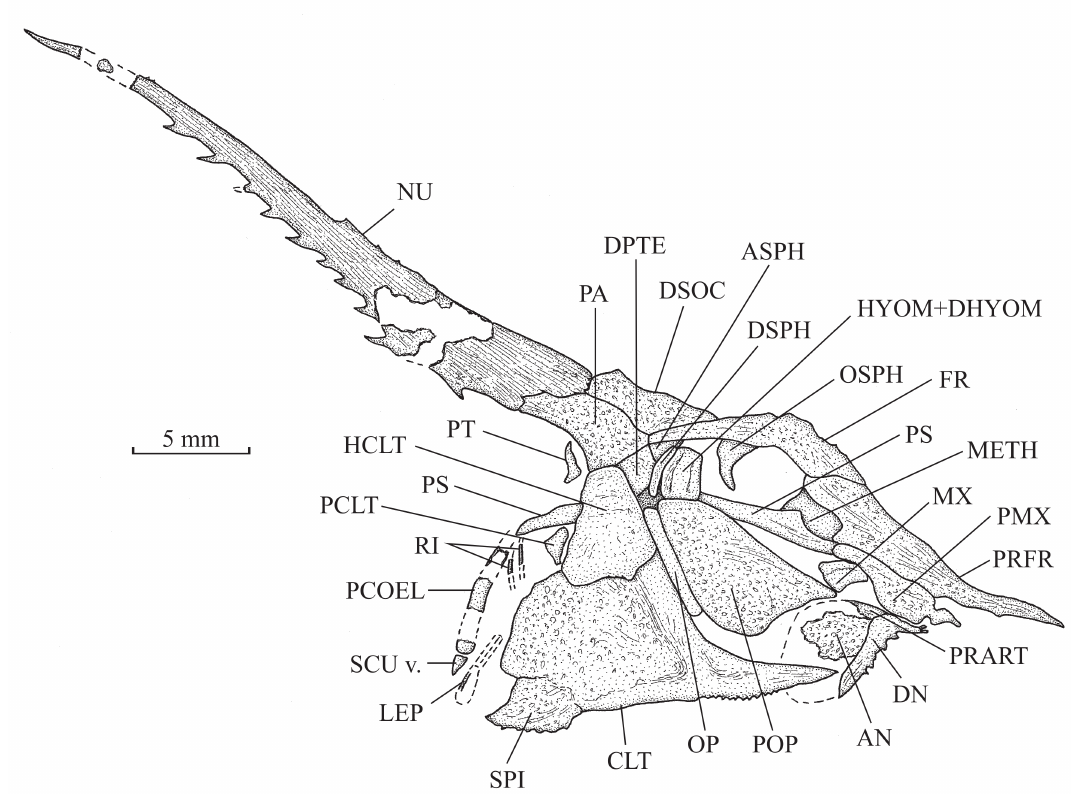
Fig. 19. Pankowskichthys libanicus gen. et sp. nov. Reconstruction of the skull and the pectoral girdle based on holotype, IRSNB